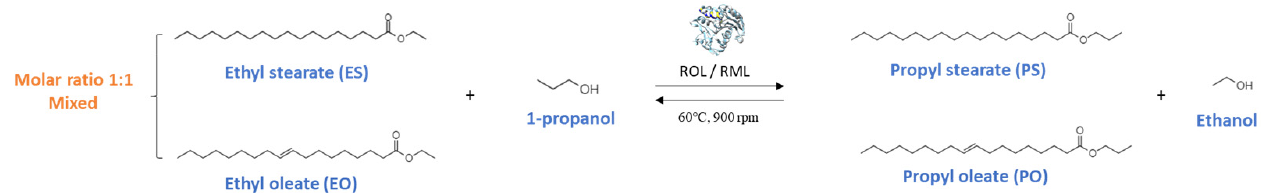
Figure 1. Transesterification reactions of ROL or RML with 1:1 molar mixed ES-EO and 1-propanol. The product PS and PO were quantified with gas chromatography (GC) and the relative activities V EO /V ES of ROL and RML were, respectively calculated and compared. The substrate preference of the two lipases was expressed as an activity ratio: V ES /V EO . The activity was calculated as the initial production rate of propyl stearate (PS) and propyl oleate (PO) (from ES and EO) in the transesterification reactions, with either of the two lipases. The concentration of PS and PO in the samples was plotted versus time to draw the reaction progress curve and the initial velocity was calculated as the slope of the linear region of the progress curve. (Plots are shown in supplementary File S1). V ES and V EO of both lipases with different enzyme dosages, together with the relative activity (V ES /V EO ), are listed in Table 1. With each dosage of lipase, the reaction was repeated in triplicate. Table 1. Activity profiles of ROL and RML in